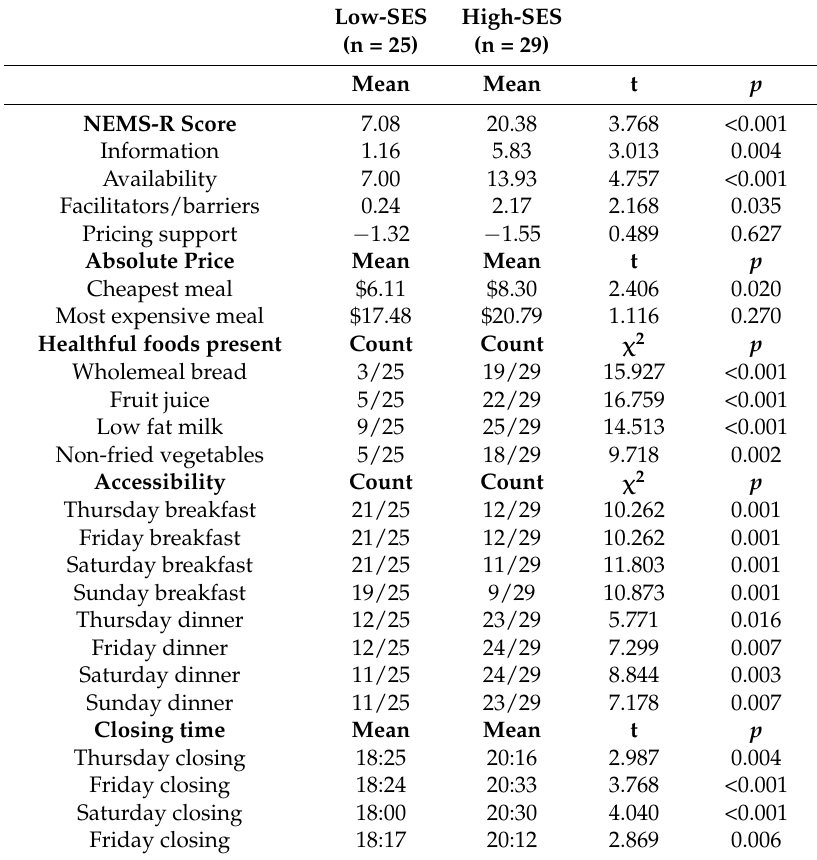
Table 1. Indicators of support for healthful eating by suburb socio-economic status (SES) for eating